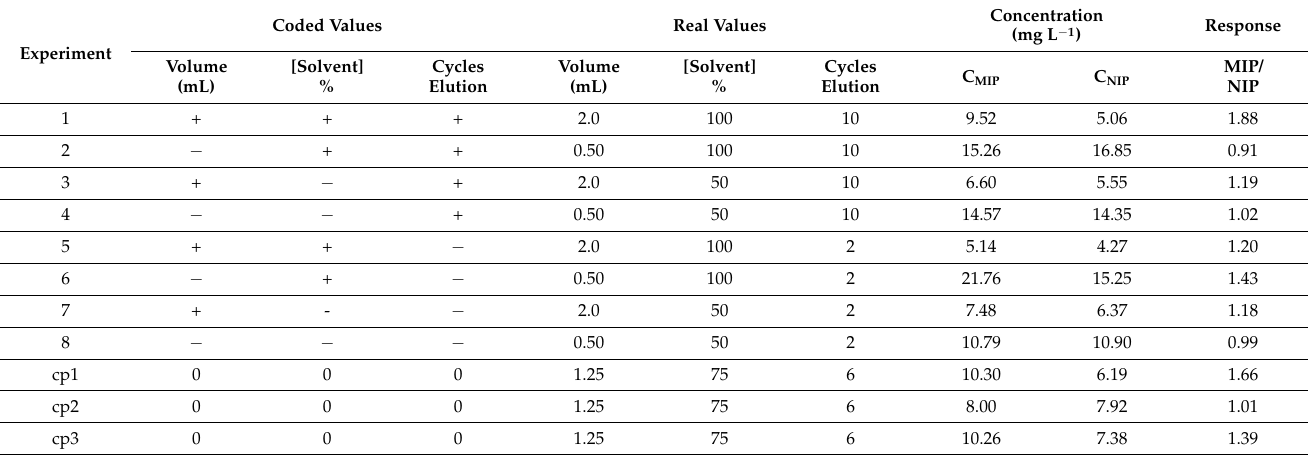
Table 3. The 2 3 factorial design parameters and analytical response for the MISPE-DPX elution